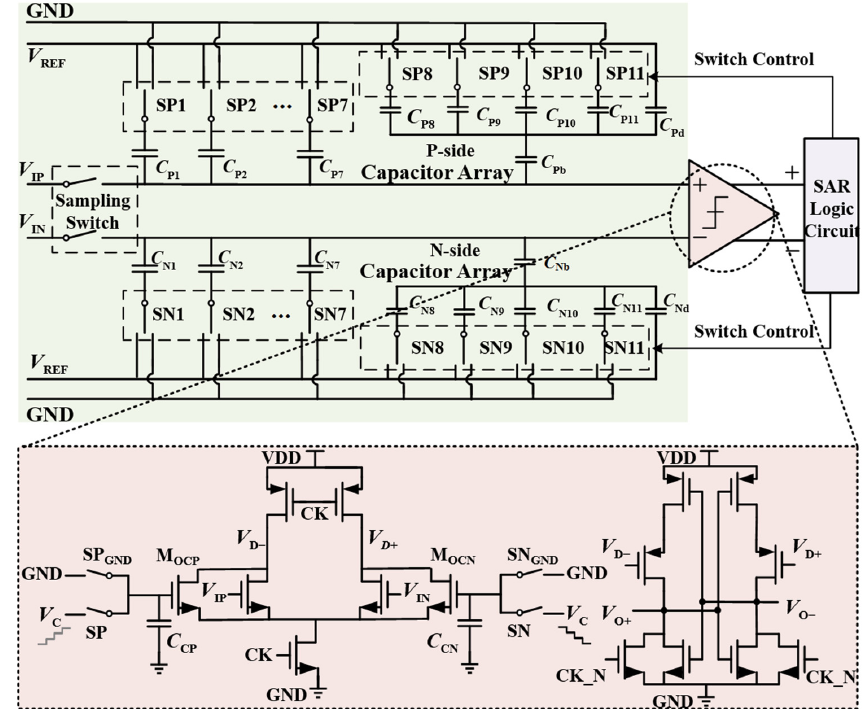
Figure 3. The structure of SAR ADC.